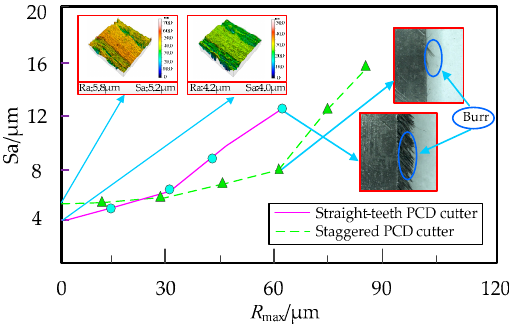
Figure 9 . Comparison of the surface quality between the two PCD cutters.